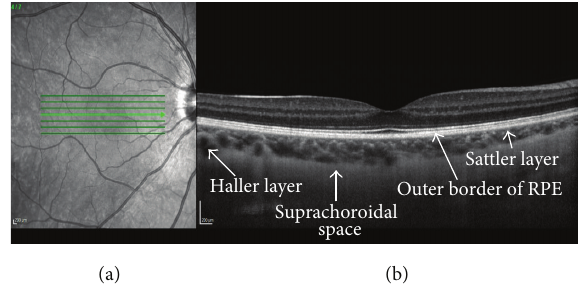
Figure 1: Enhanced depth optical coherence tomographic B-scan using a Heidelberg Spectralis OCT (Heidelberg Engineering, Ger- many). (a) Near-infrared fundus image, (b) corresponding EDI- OCT demonstrating normal retinal and choroidal anatomy at the macula. Note that both retinal and choroidal layers can be clearly identified on the same